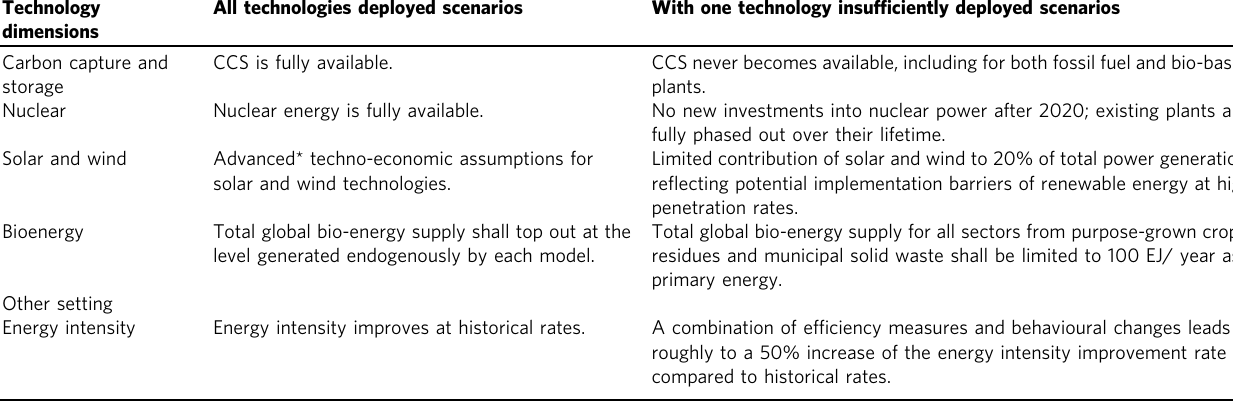
Table 1 Technology settings in AMPERE scenarios. Technology All technologies deployed scenarios With one technology insuf fi ciently deployed scenarios dimensions Carbon capture and